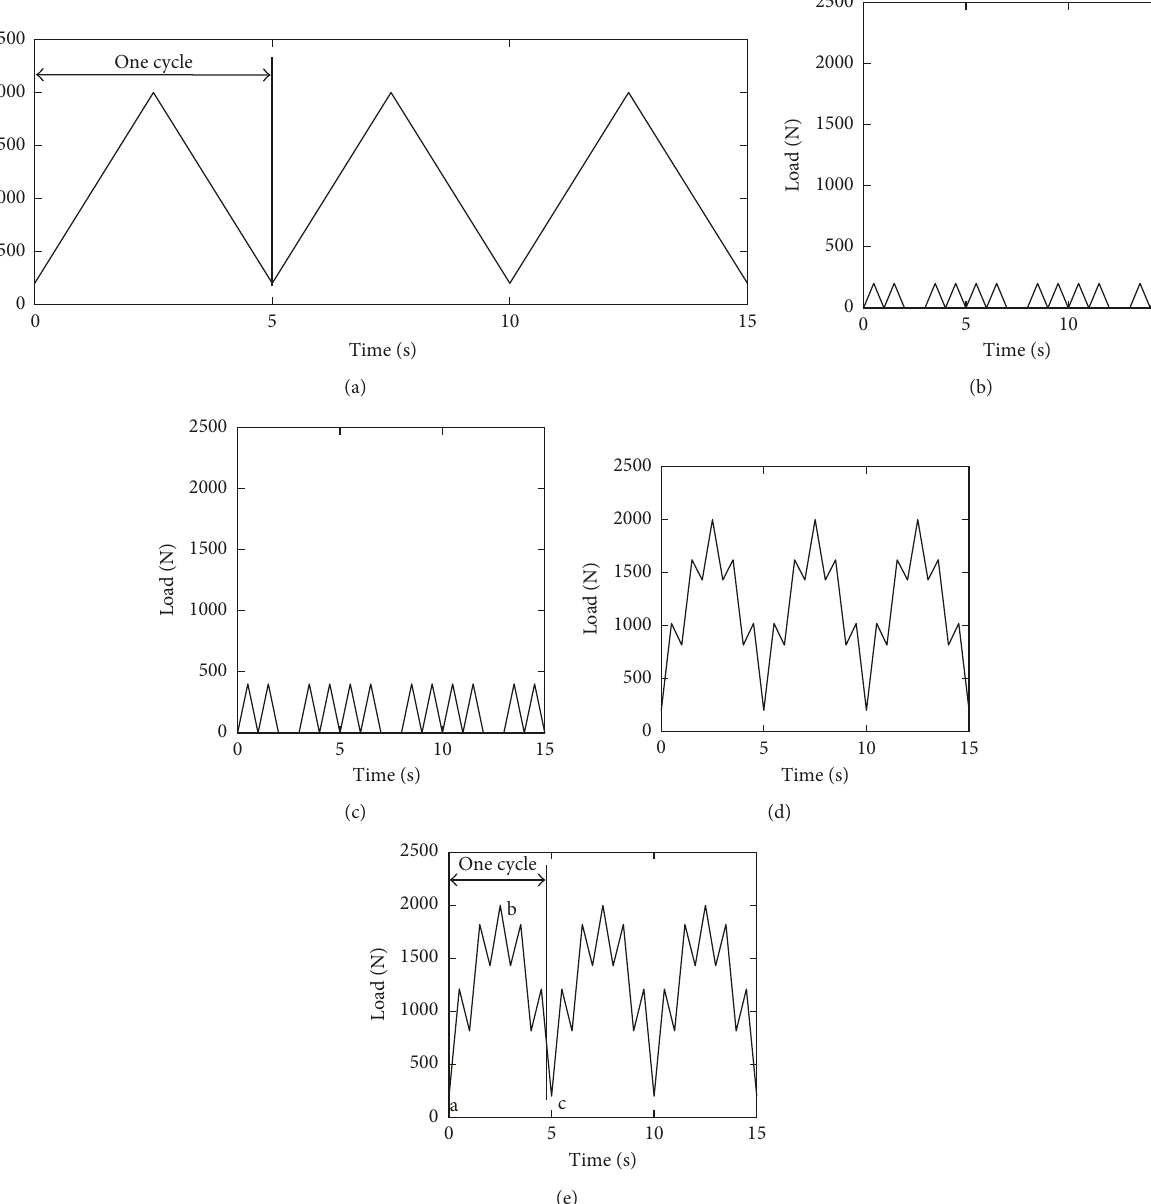
Figure 6: Applicable loading conditions: (a) baseline; (b) 10% low ratio; (c) 20% high ratio; (d) superimposed loading with 10% low ratio; (e) superimposed loading with 20% high